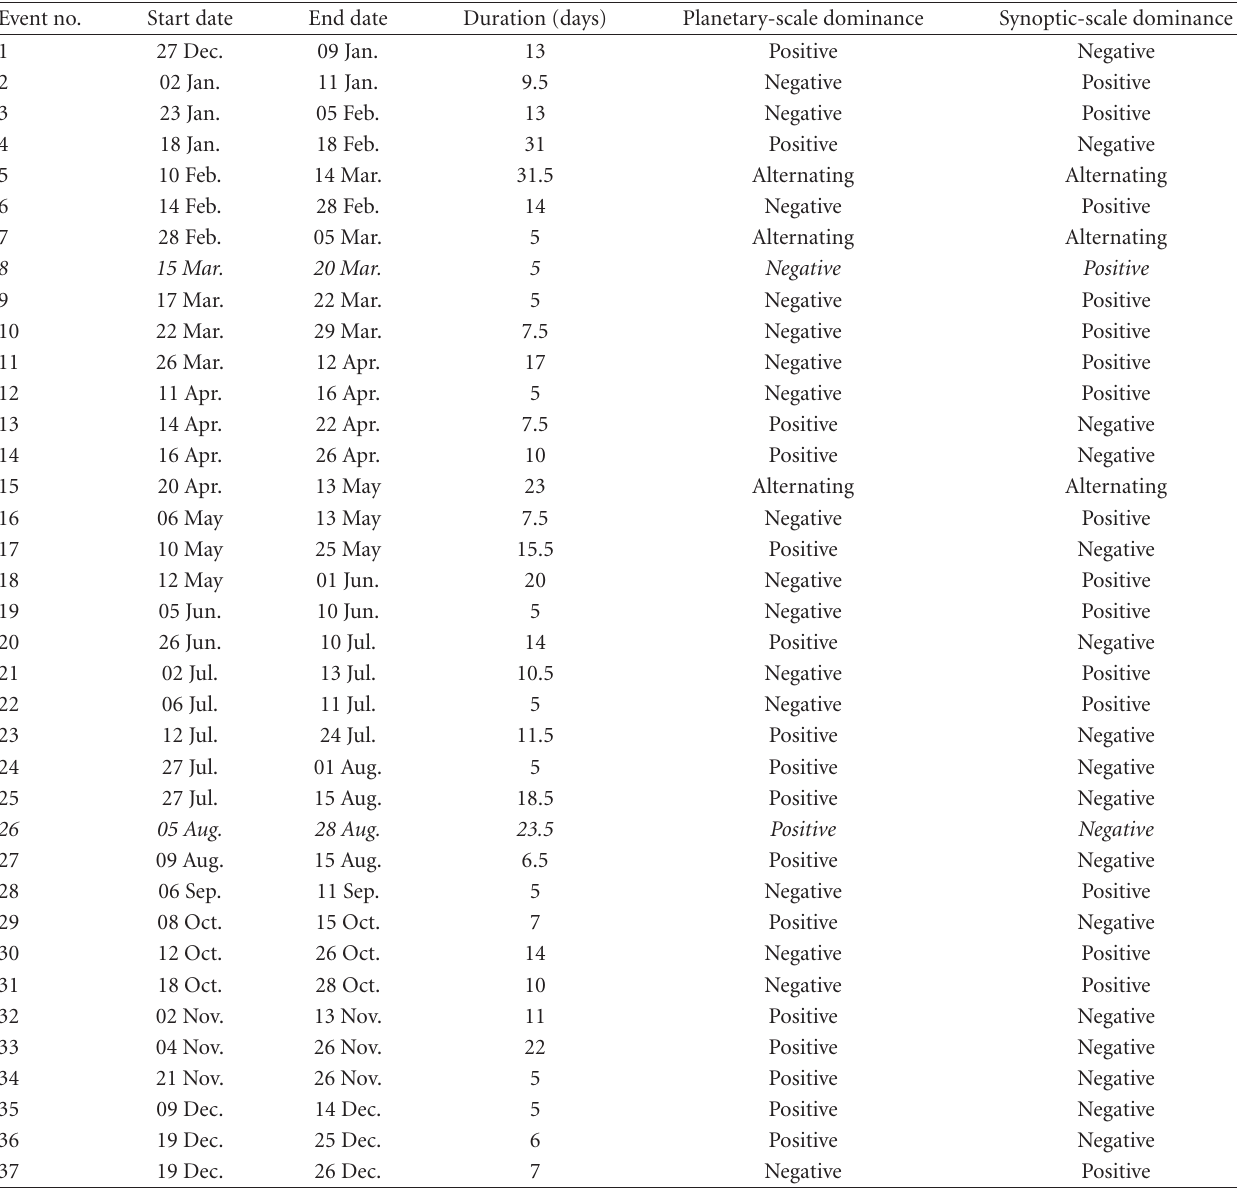
Table 6: Same as Table 5 except for the year